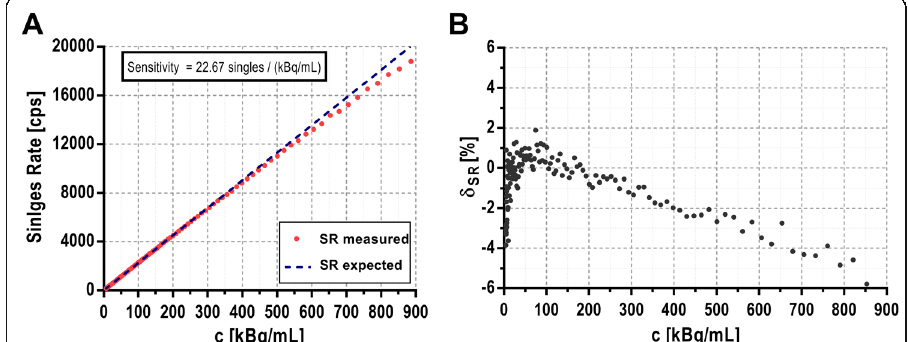
Fig. 4 a Single rate (SR) detected by the detector as a function of activity concentration (c, red dots) inside the catheter. A linear fit of the measured SR at low c when count rate losses are negligible is also shown (blue dashed line). b Count rate losses ( δ SR) as a function of activity